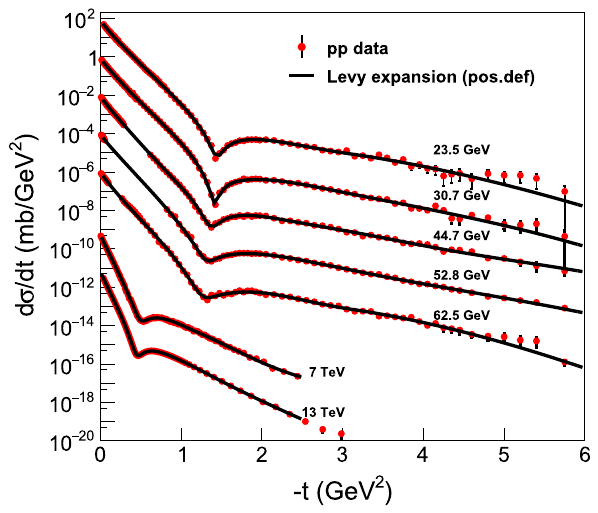
Fig. 4 Summary plot of the model-independent, fourth-order Lévy expansion fits to the elastic pp scattering data at ISR and LHC energies √ s = 23 . 4 GeV up to 13 TeV. These fits are detailed ranging from from in “Appendix A”